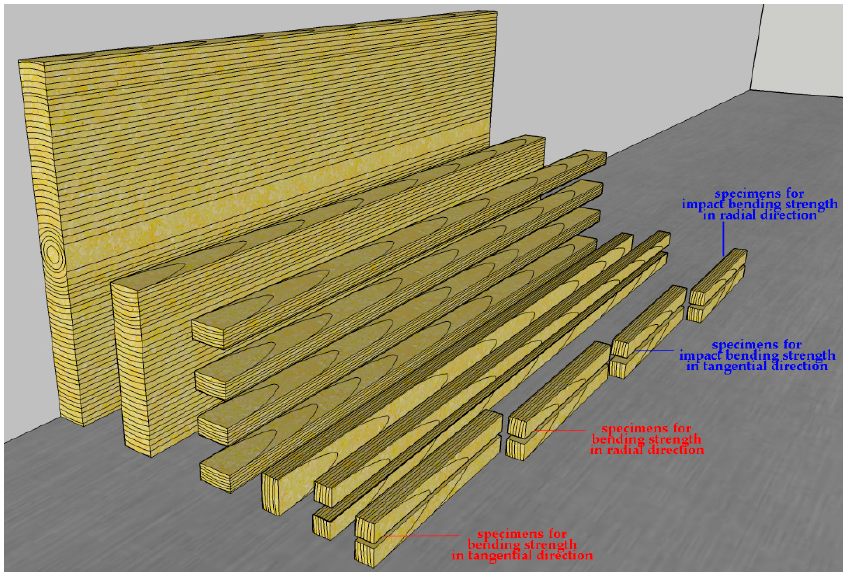
Figure 1. Scheme of preparation of test specimens from the central board.